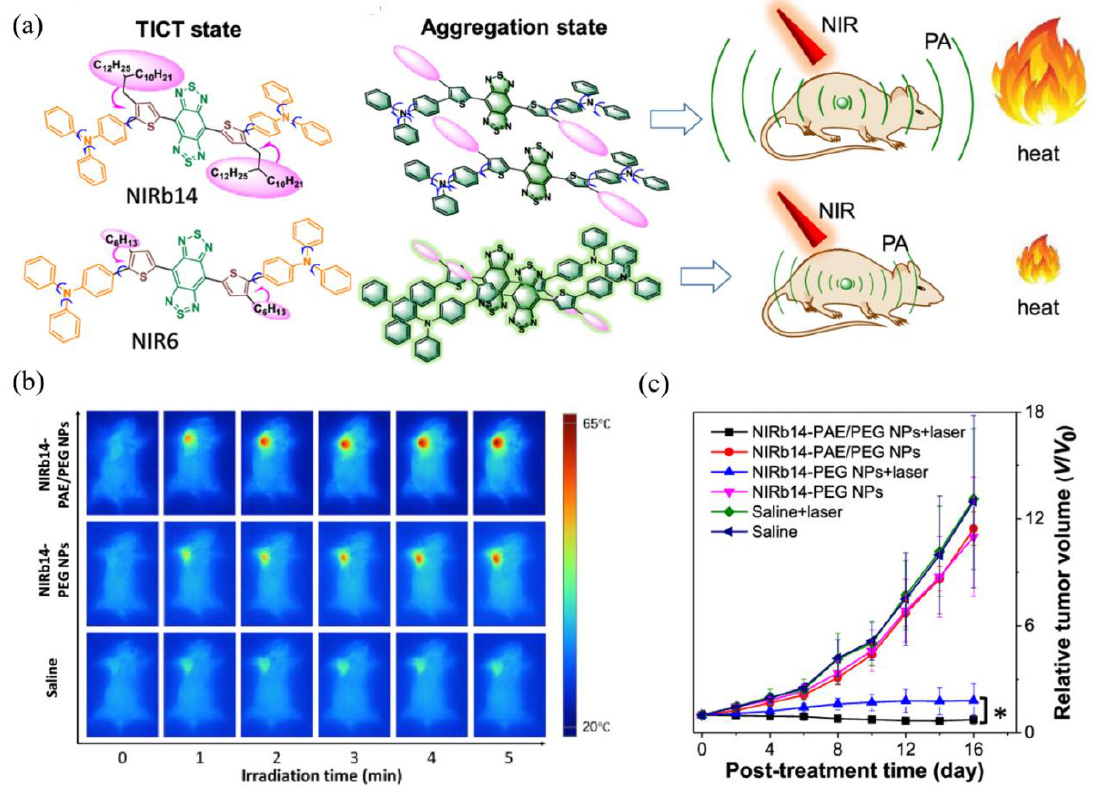
Figure 4. ( a ) Molecular structure and the schematic illustration of the NIR-II fluorophores TICT state in solution, in aggregation state, and the scheme for PAI-guided PTT; ( b ) infrared radiation thermal images of mice with 4T1 tumor under 808 nm laser irradiation; ( c ) tumor growth curves of different treatment groups after 16 days. *: V/V 0 < 0.05 comparing “NIRb14-PAE/PEG NPs + laser” and “NIRb14-PEG NPs + laser” groups. Reprinted with permission from Ref. [52]. Copyright 2019, American Chemical Society.